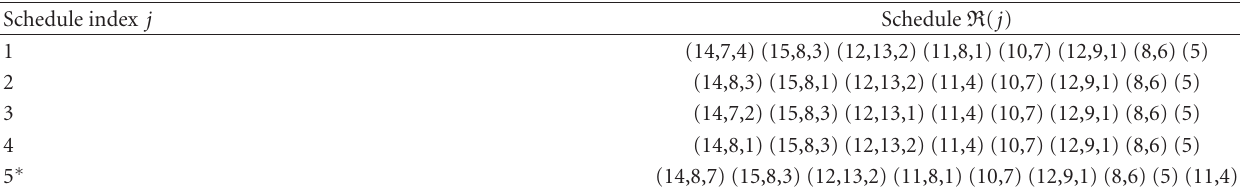
Table 3: Feasible schedules of M 1 .